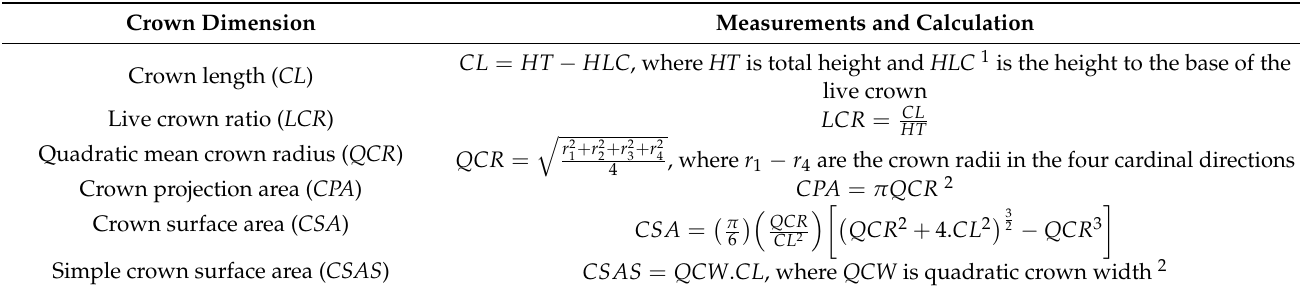
Table 1. Calculated crown dimensions used in this